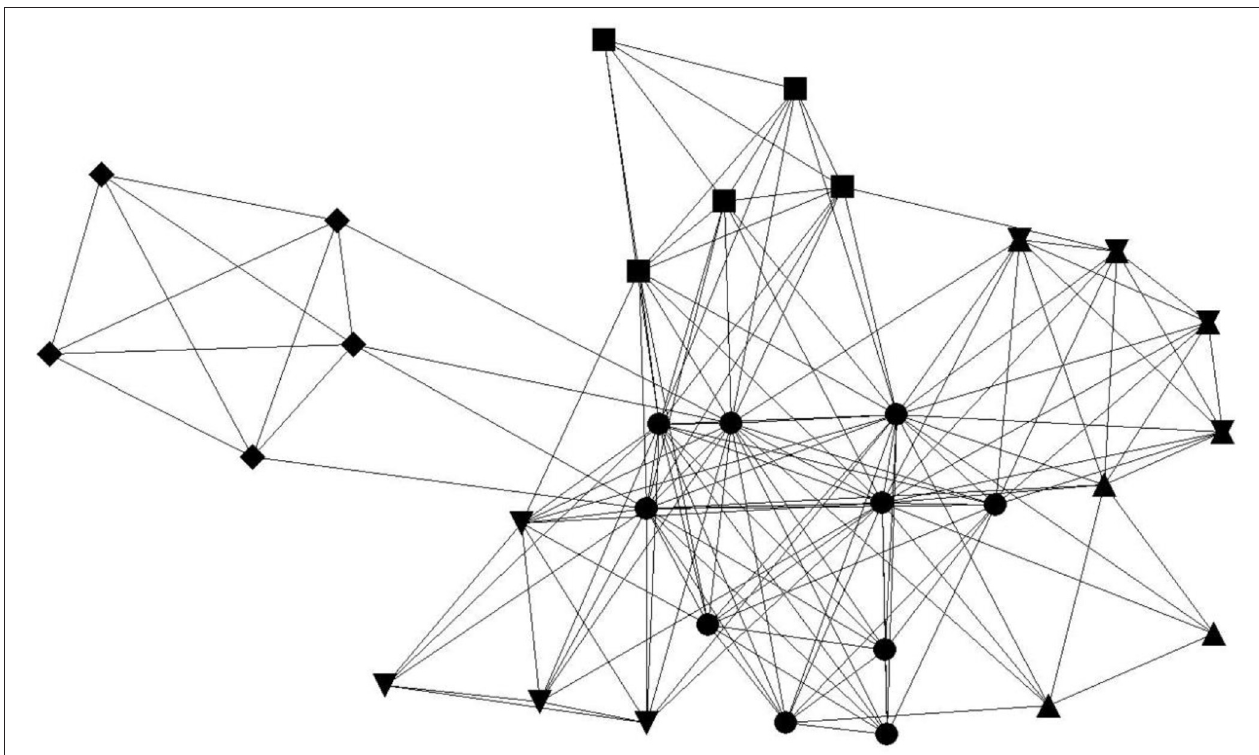
FIGURE 1 | This graph shows the network prior to the 90-day cycle. Participants answered the survey question, “Who did you know prior to PiPNIC?” The graph, constructed in UCINET, includes all participants ( n = 31). The non-circle nodes are educators, circles are researchers, and the shape indicates organizational affiliation. More highly connected nodes are moved to the center, while people with fewer connections are moved to the periphery.